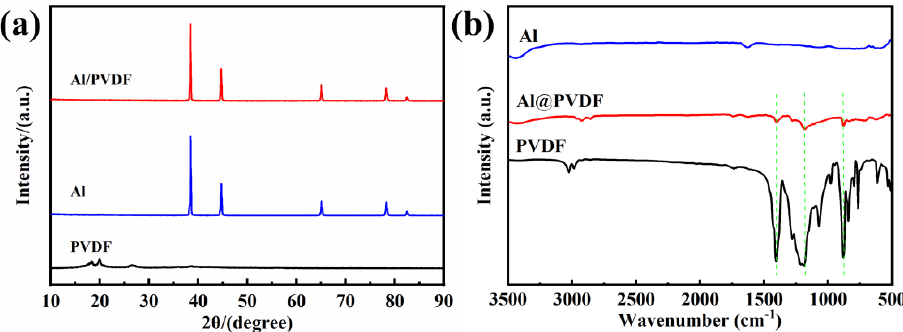
Figure 3. XRD patterns ( a ) and FTIR spectra ( b ) of Al powders, Al@PVDF powders, and PVDF